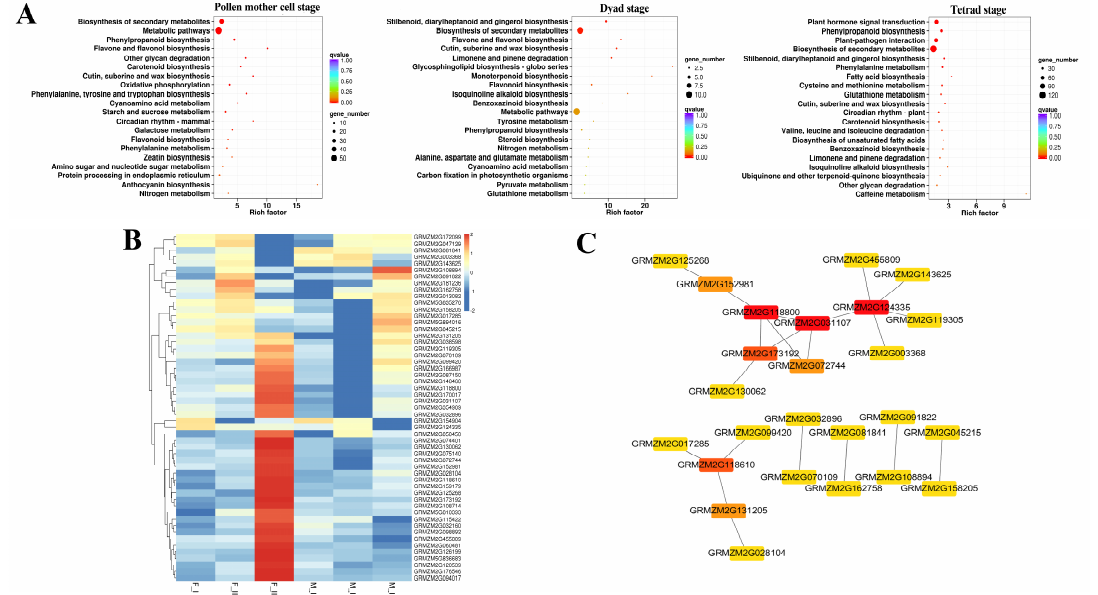
Figure 4. ( A ) KEGG enrichment analysis in ms305 and fertile sibling anther at different development stages. ( B ) Heat maps of differentially expressed genes in ‘cutin, suberine, and wax biosynthesis’ and ‘lipid metabolism’ pathway; I, II, and III represent PMC, dyad, and tetrad stage (III), respectively; F, fertile sibling; M, ms305 . ( C ) Molecular interaction network conducted by using Cytoscape, the darkness for the node degree of genes.